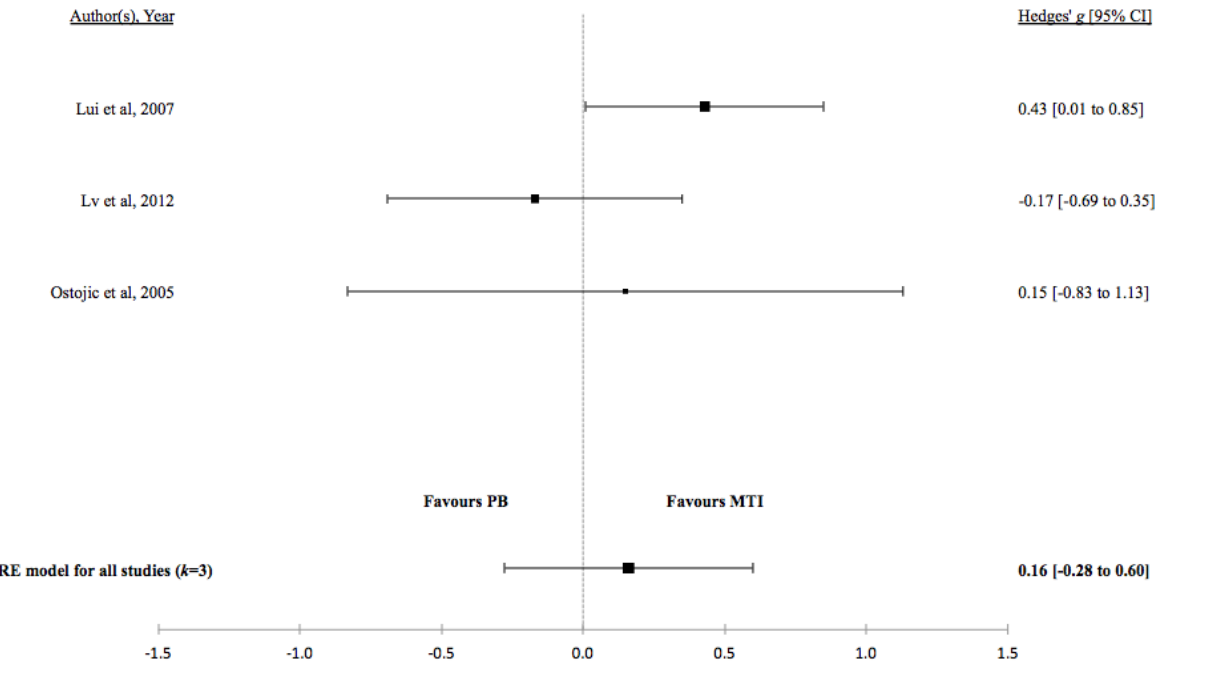
Figure 7. Forest plot of the standardized mean difference in lung function between MTI and paper-based group. MTI: mobile technology intervention.